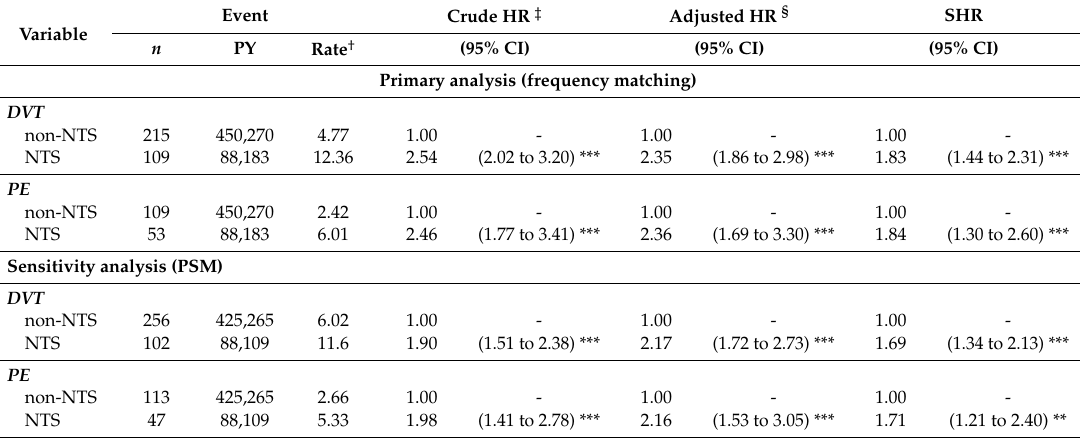
Table 4. Cox proportional hazard regression models for risk of DVT and PE in primary and sensitivity analyses.